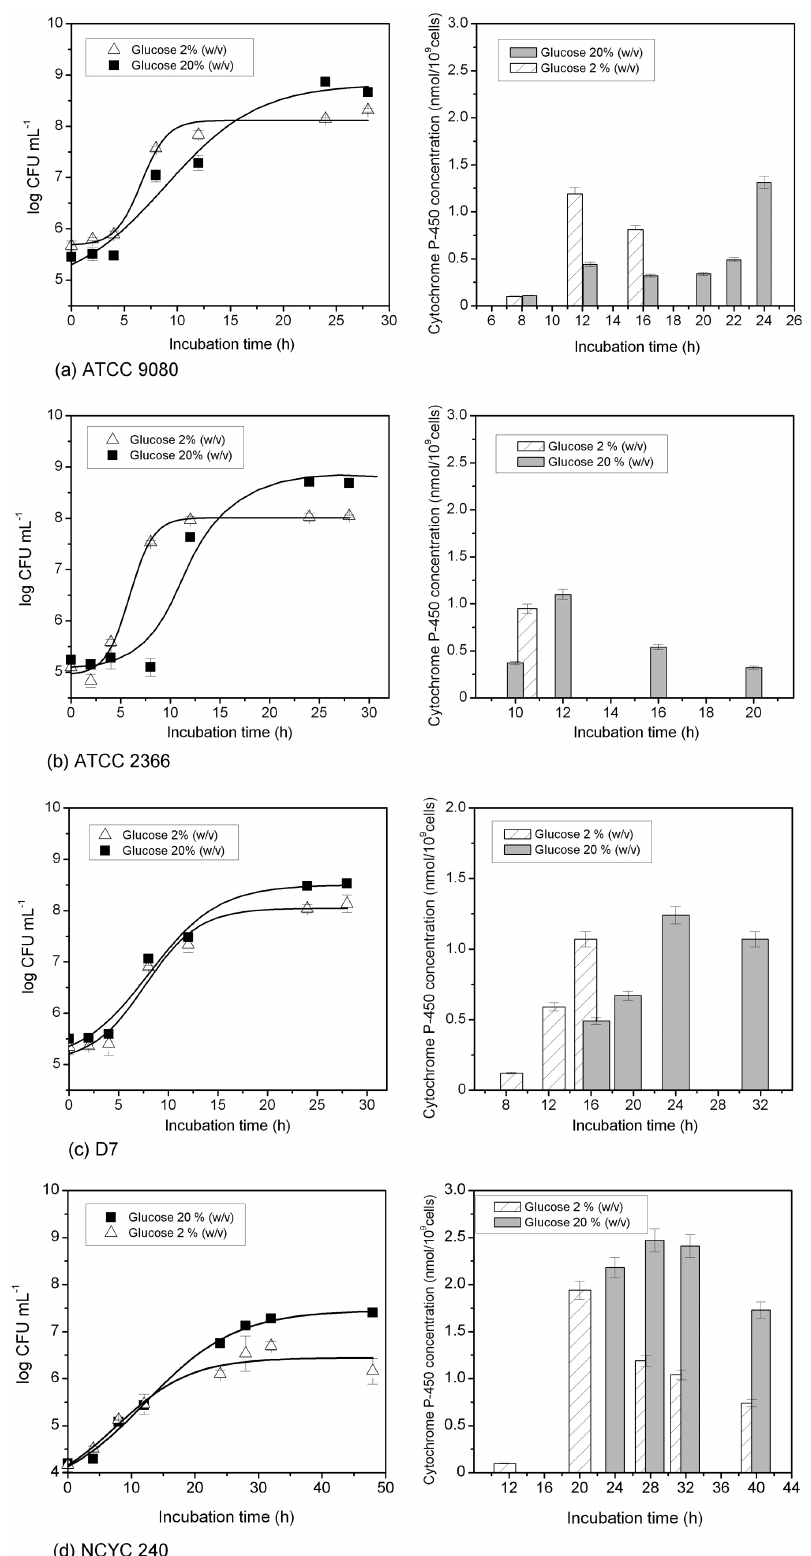
FIGURE 3 - Growth curves and cytochrome P-450 concentrations of different Saccharomyces cerevisiae strains cultured in media containing 2 % (w/v) and 20 % (w/v) glucose: (a) ATCC 9080, (b) ATCC 2366, (c) D7, and (d) NCYC